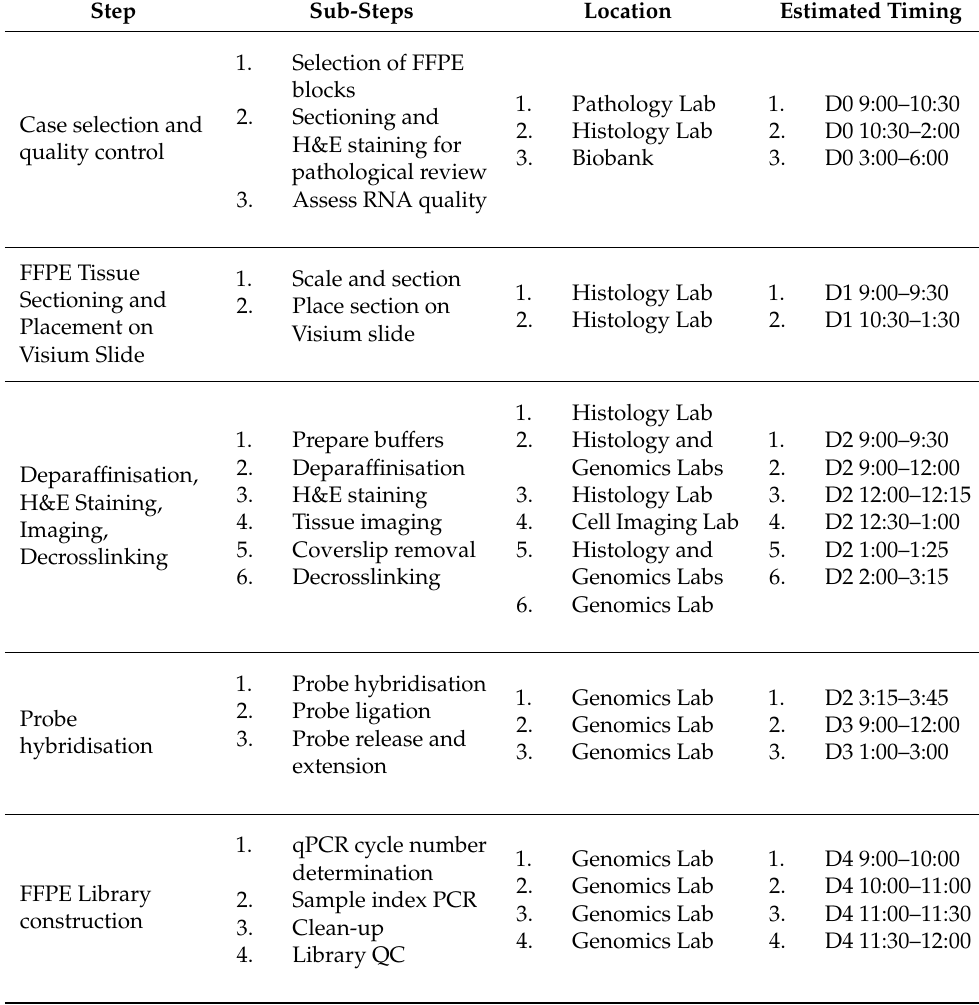
Table 1. A step-by-step plan of the Visium workflow. D—day; FFPE—formalin-fixed paraffin- embedded; H&E—hematoxylin and